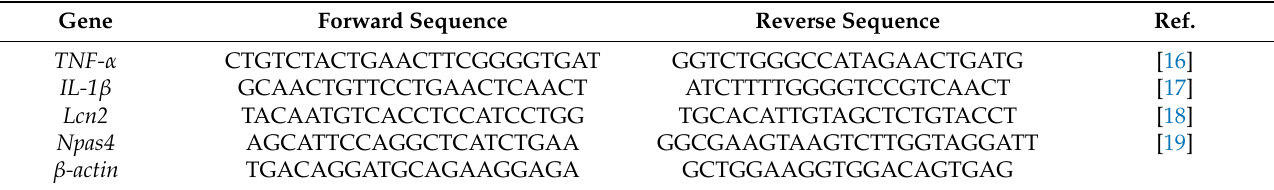
Table 1. Sequence of primers used in qRT-PCR.